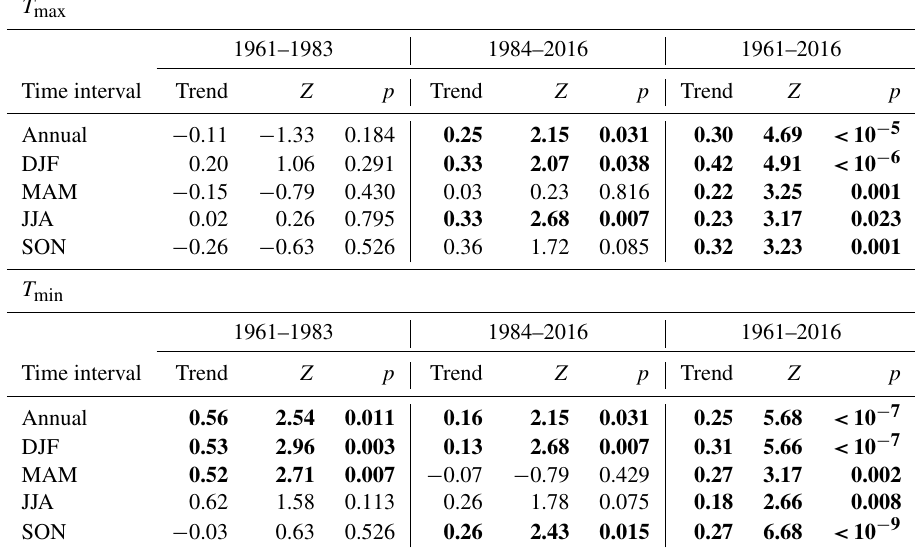
Table 2. Modified Mann–Kendall trend test results for period 1, from 1961 to 1983; period 2, from 1984 to 2016; and all the analysed years, from 1961 to 2016, considering each season and on an annual basis, for the daily maximum ( T max ) and minimum ( T min ) temperatures. The trend was estimated as the slope of the linear fit between the variable of interest and year. Bold numbers refer to statistically significant trend values at the 95% confidence level.